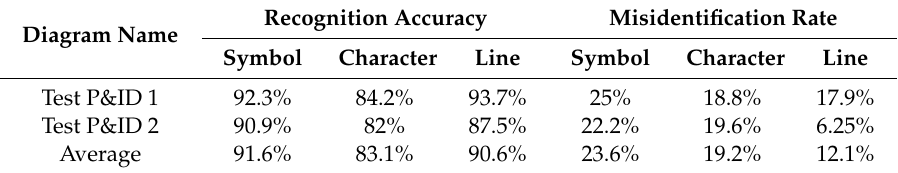
Table 2. Recognition accuracies and misidentification rates for test P&IDs.